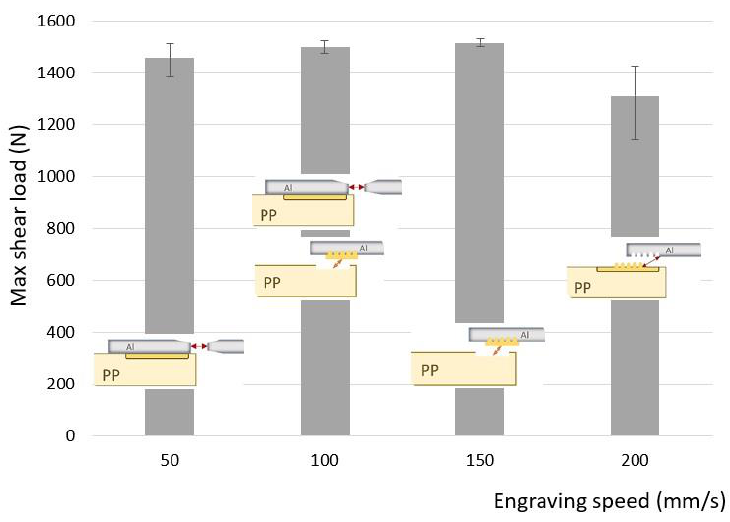
Figure 16. Maximum shear load in the function of the engraving speed (mm/s) with the different failure modes.